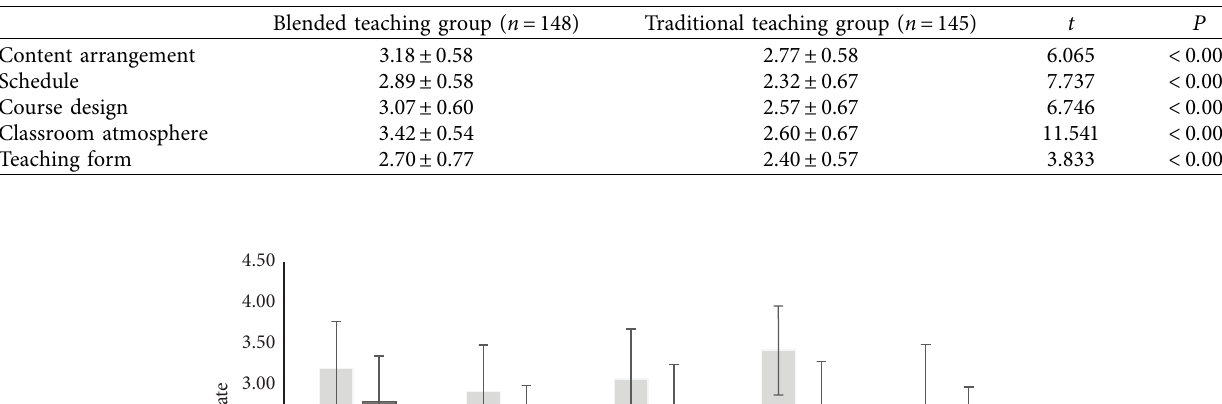
Figure 1: Comparison of fnal examination results between the blended teaching group and traditional teaching group. Table 2: Comparison of satisfaction rate between the blended teaching group and traditional teaching group ( x ± SD,